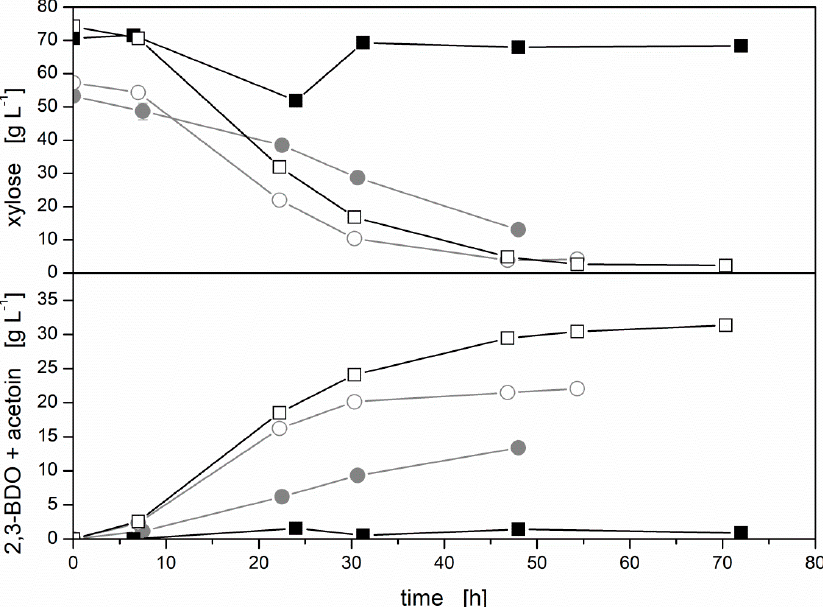
Figure 4. Production of 2,3-BDO and acetoin using two different concentrated birch wood hydroly- sates: ultrafiltrate (UF, black, closed square), acetate reduced UF (black, open square), nanofiltrate (NF, grey, closed circle), acetate reduced NF (grey, open circle). Cultivation of B. vallismortis B-14891 using UF and NF was performed in duplicates in 24 well microtiter plates at 37 °C and 320 rpm and using acetate reduced UF and NF in 250 mL reactor with aeration rate of 25 sL h − 1 air, an agitation speed of 300 rpm and an initial pH of 6.6 ± 0.1 and pH control at pH 5.8 with 4 M NaOH during the cultivation. Essential media compounds were added.